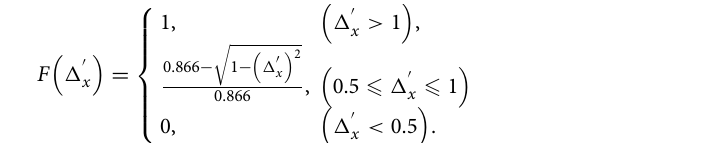
Its horizontal probability distribution indicates that the expected horizontal relative exposure is: